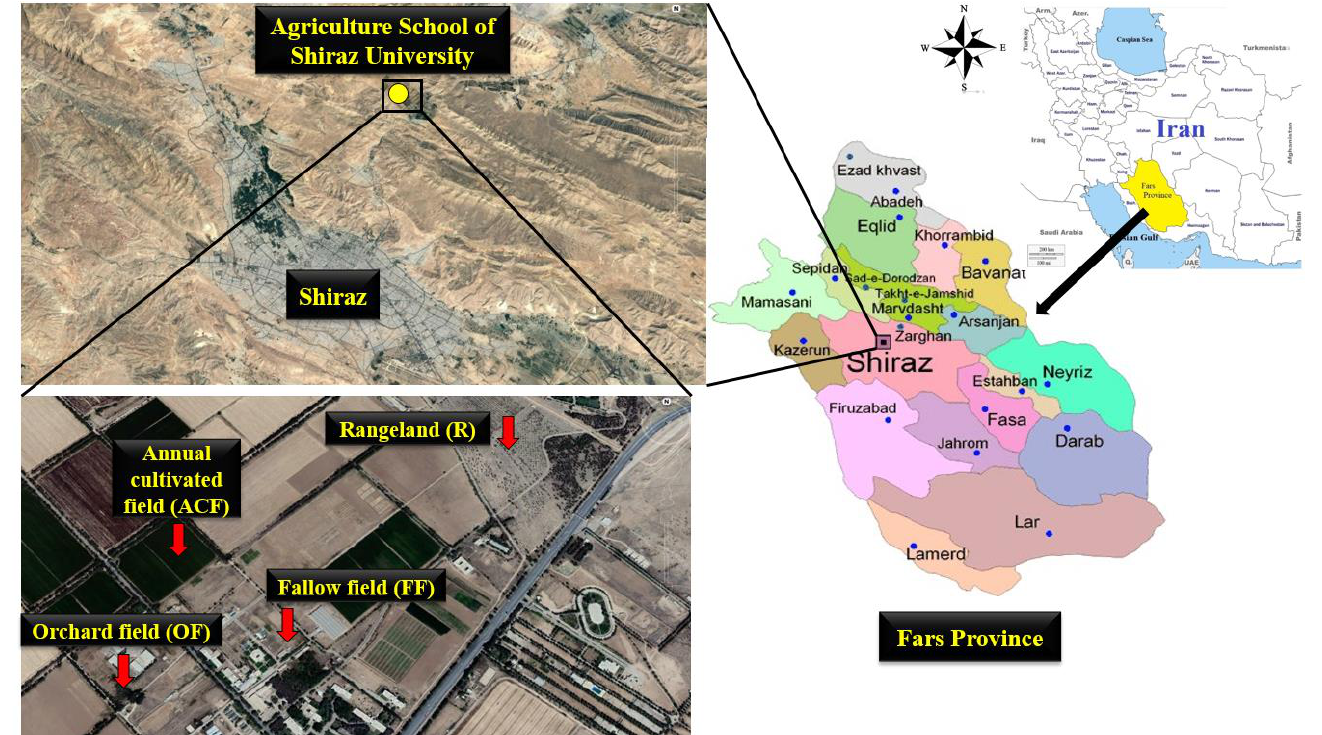
Figure 1. Geographical map of study area and sampling sites.